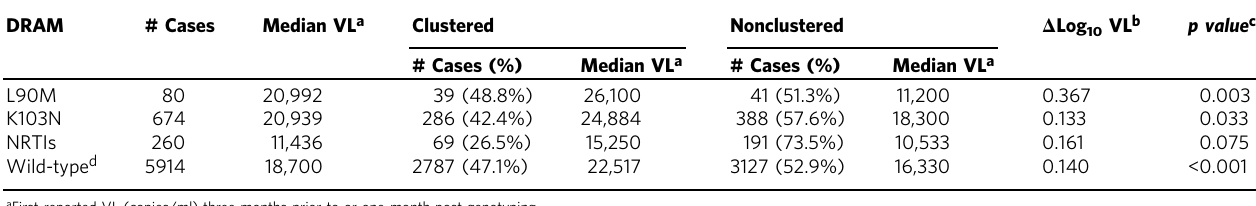
Table 3 Median viral load (VL) in clustered and nonclustered individuals with HIV diagnosed at stage 1 infection in people with drug-resistant virus, United